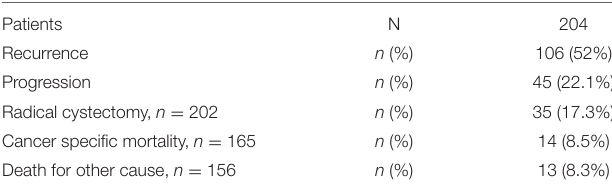
TABLE 2 | Recurrence, progression and mortality in the current series.